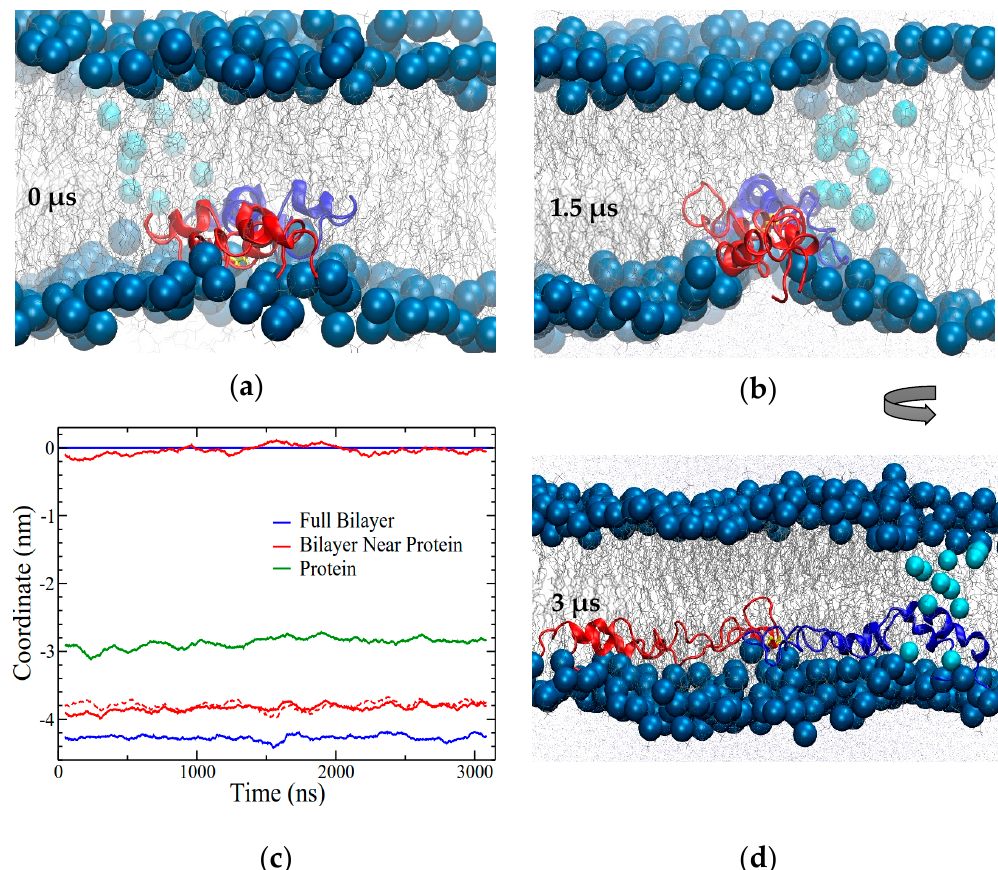
Figure 8. In the OI1 simulation SP-B promoted a crease in the bilayer and also interacted with the preformed pore. The ( a ) initial system configuration and ( b ) configuration at 1.5 µ s, looking along the long axis of the protein. The lipid headgroups in the preformed pore are shown with cyan (lighter) blue to help di ff erentiate them from the lipids in the SP-B-induced crease. ( c ) Maximum density positions of phosphorous atoms from lipid headgroups in the bilayer overall (blue) and within 0.5 nm lateral distance from the protein (red), illustrating bilayer thickness. All coordinates are in reference to the overall top leaflet position. The dashed line corresponds to the di ff erence between the top and bottom solid red lines. Green shows the position of maximum density of the protein. The data are running averages over 50 points. ( d ) Final system configuration at 3.135 µ s, with the view rotated 90 ◦ from (b). The blue subunit contacted the preformed pore at approximately 2 µ